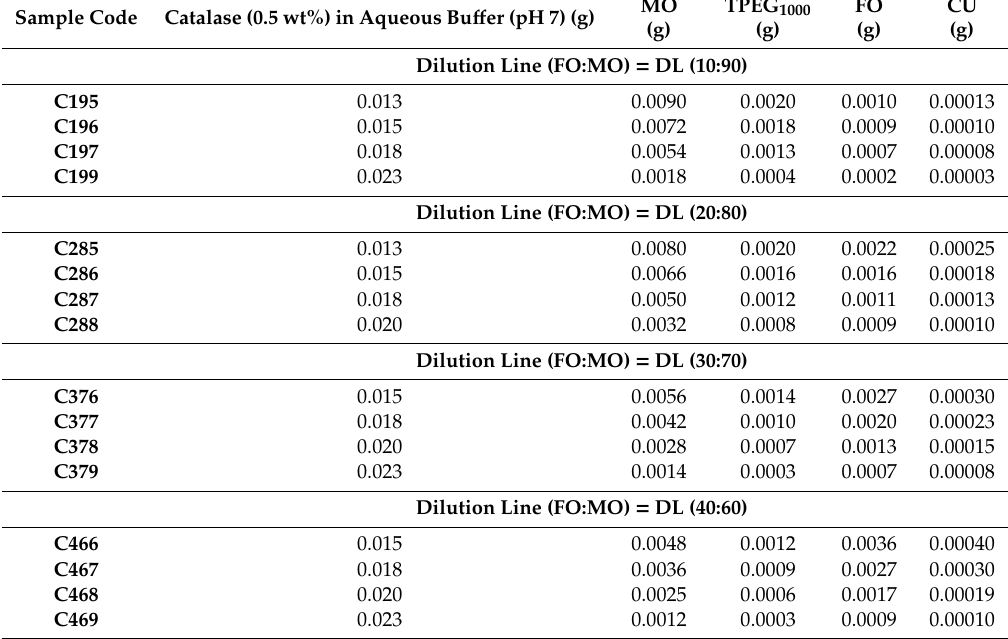
Table 3. Compositions of bulk liquid crystalline phases presented as mass proportions of MO, TPEG 1000 , FO, CU and catalase.